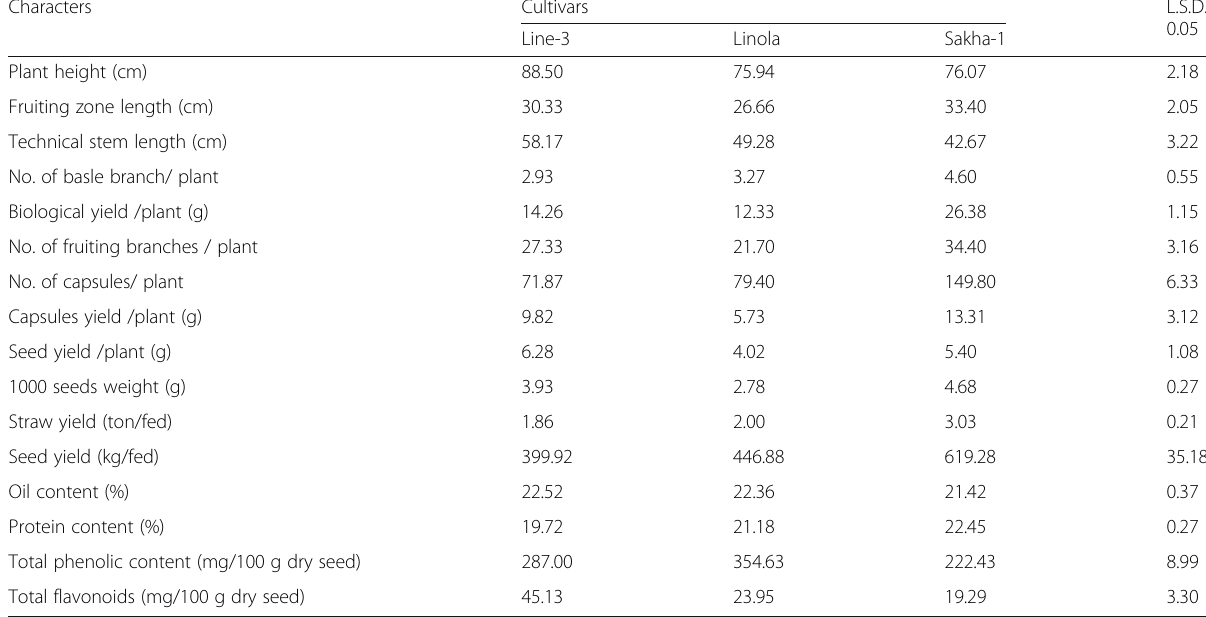
Table 4 Variations in seed yield, its related characters, and nutritive value between three flax cultivars grown under sandy soil